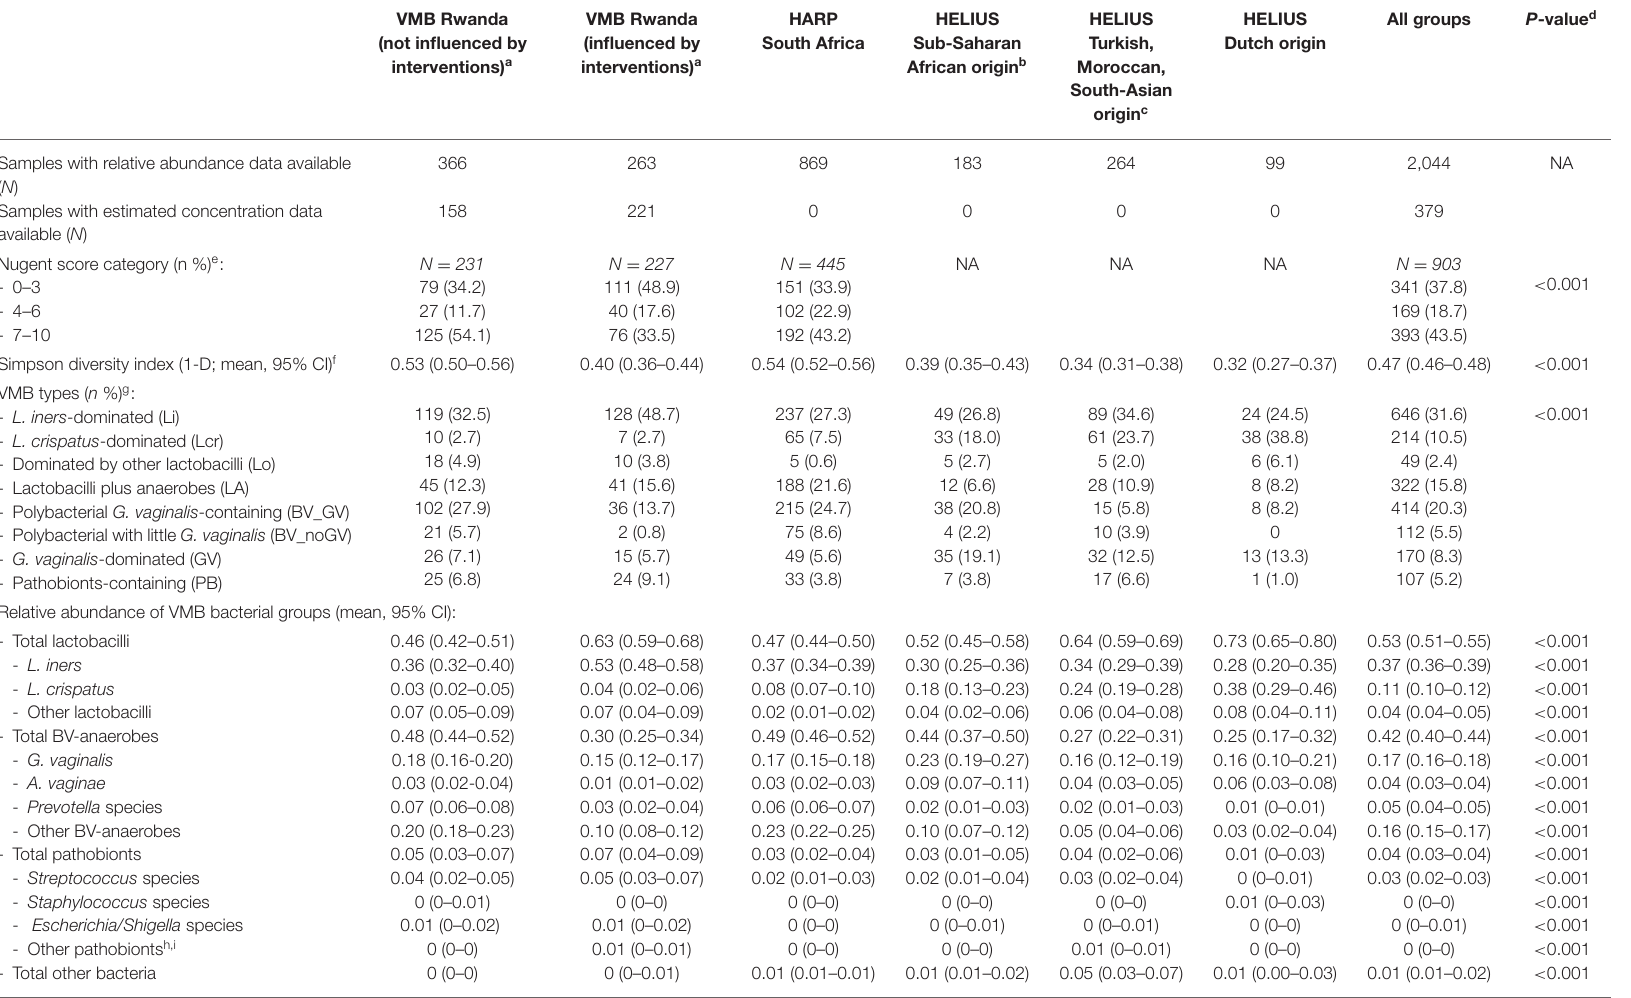
TABLE 3 | Overview of VMB composition characteristics by study, stratified by intervention exposure (VMB Rwanda) and ethnic group